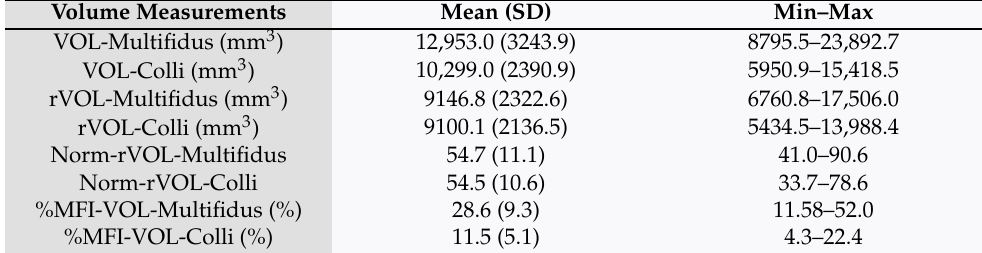
Table 4. MRI volume measures of the neck